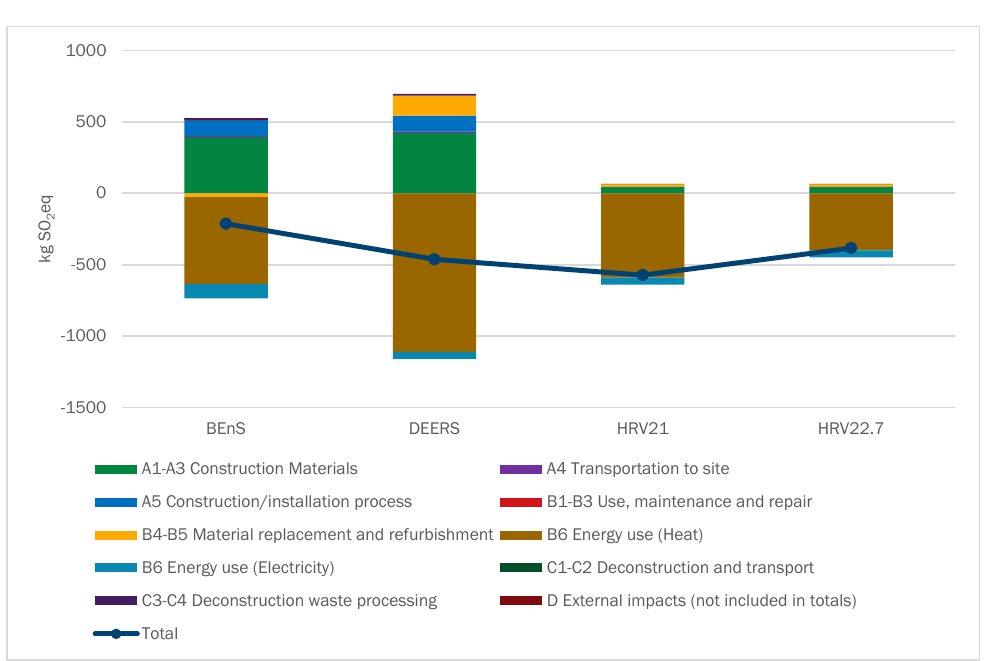
Figure 3. Acidification potential (SO 2 eq).